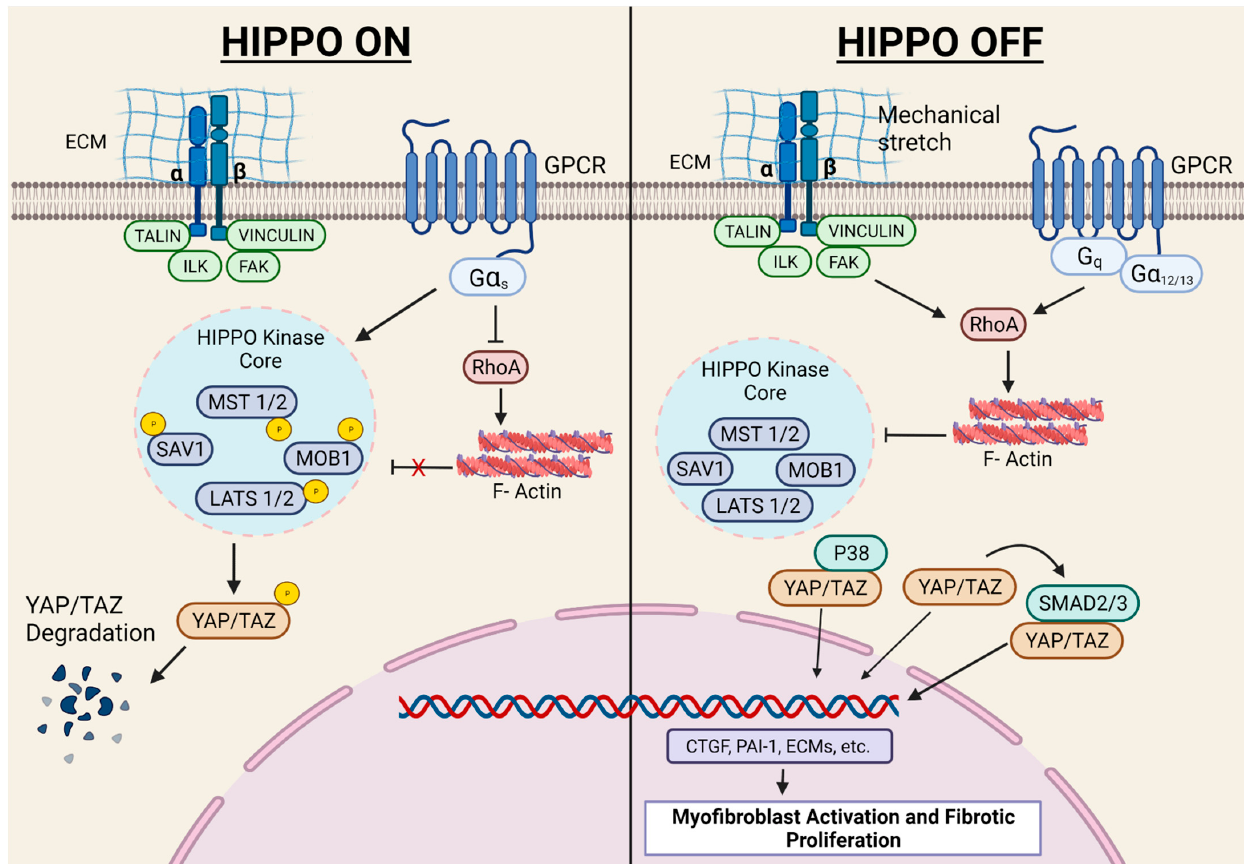
Figure 4. Hippo pathway and myocardial fibrosis. When Hippo signaling is on (left), the mammalian STE20-like protein kinase 1 (MST1), MST2, and the Sav family WW domain-containing protein 1 (SAV1) complex activate the large tumour suppressor homologue 1 (LATS1) and LATS2 kinases, which in turn phosphorylate and promote the degradation of the downstream effectors YAP and TAZ. When Hippo signaling is off (right), YAP and TAZ function as transcriptional co- activators and partner with different transcription factors to regulate gene transcription. Active Hippo signaling is essential to maintain fibroblasts in their inactive state (calm). However, Hippo signaling is switched off in activated fibroblasts, leading to YAP/TAZ nuclear localization for the mediation of pro-fibrotic signaling (right). CTGF = Connective tissue growth factor; ECM = Extracellular matrix; FAK = Focal adhesion kinase; G α and Gq = G protein subunit; ILK = Integrin- linked kinase; LATS 1/2 = Large Tumor Suppressor; MOB1 = Mps One Binder 1; MST 1/2 = Mammalian Ste20-like 1 and 2; PAI-1 = Plasminogen activator inhibitor-1Roa; Smad = Contraction of Sma and Mad (Mothers against decapentaplegic); TAZ = Transcriptional co-activator with PDZ-binding motif; YAP = Yes-associated